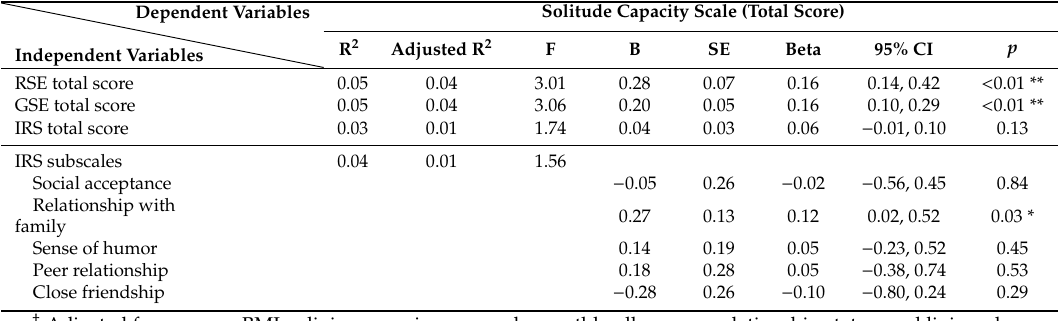
Table 3. Multiple regression analysis for identifying Solitude Capacity Scale † with total score significantly related to Rosenberg Self-Esteem Scale, General Self-E ffi cacy Scale, and Interpersonal Relationship Scale for College Students with